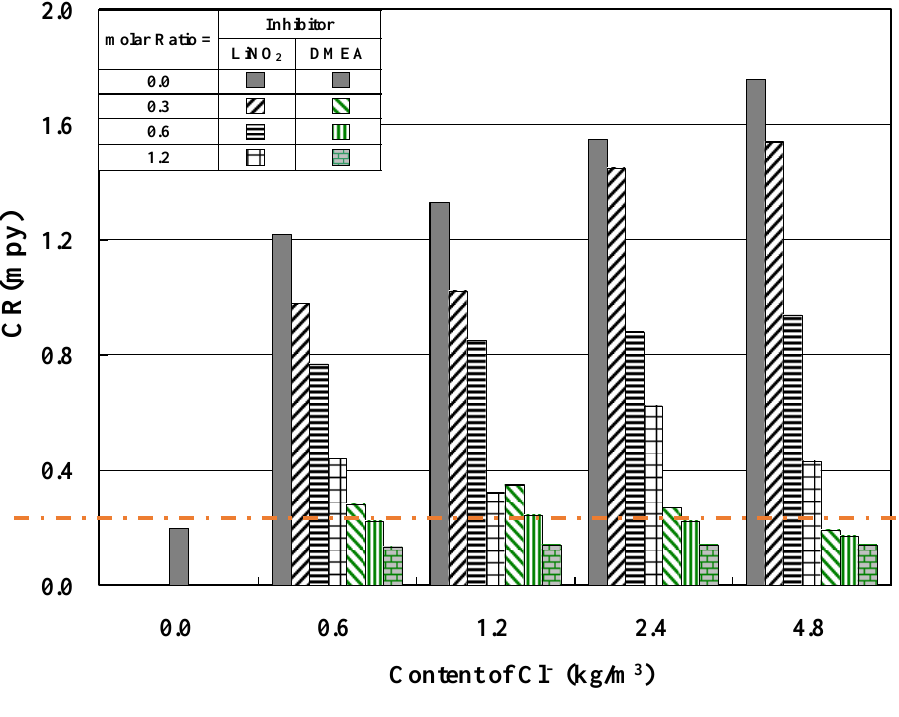
Figure 8. Relationship between corrosion rate and content of Cl − .